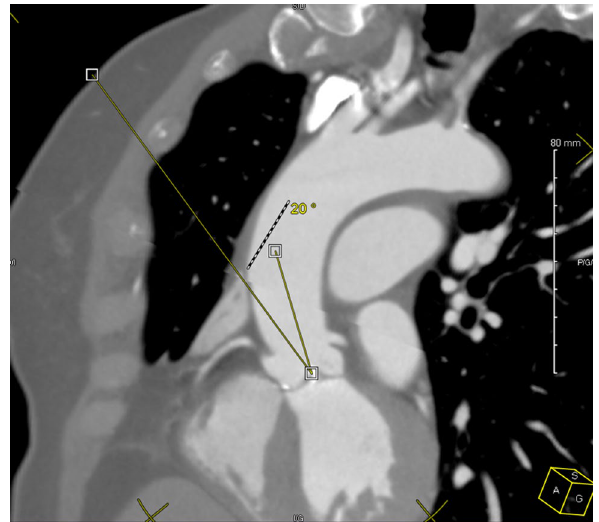
Figure 1. Elattar’s angle